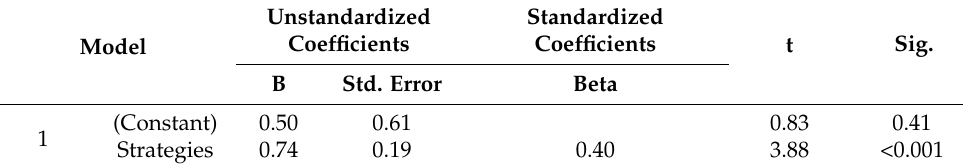
Table 9. Coefficients a